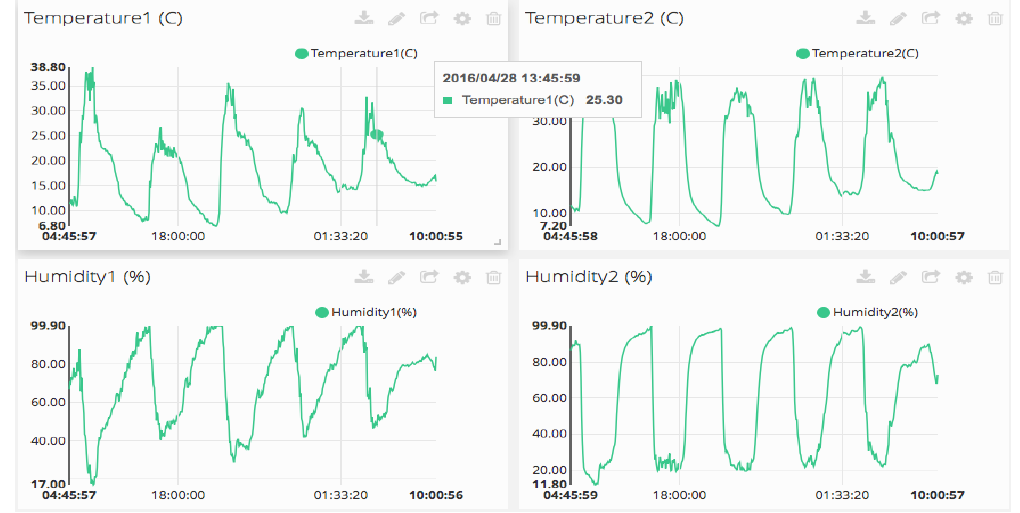
Figure 10. Example of Temperature and relative Humidity of greenhouse (in/out) showed on cloud-web server. Sampling time is defined by the agronomist. These sensors are included in